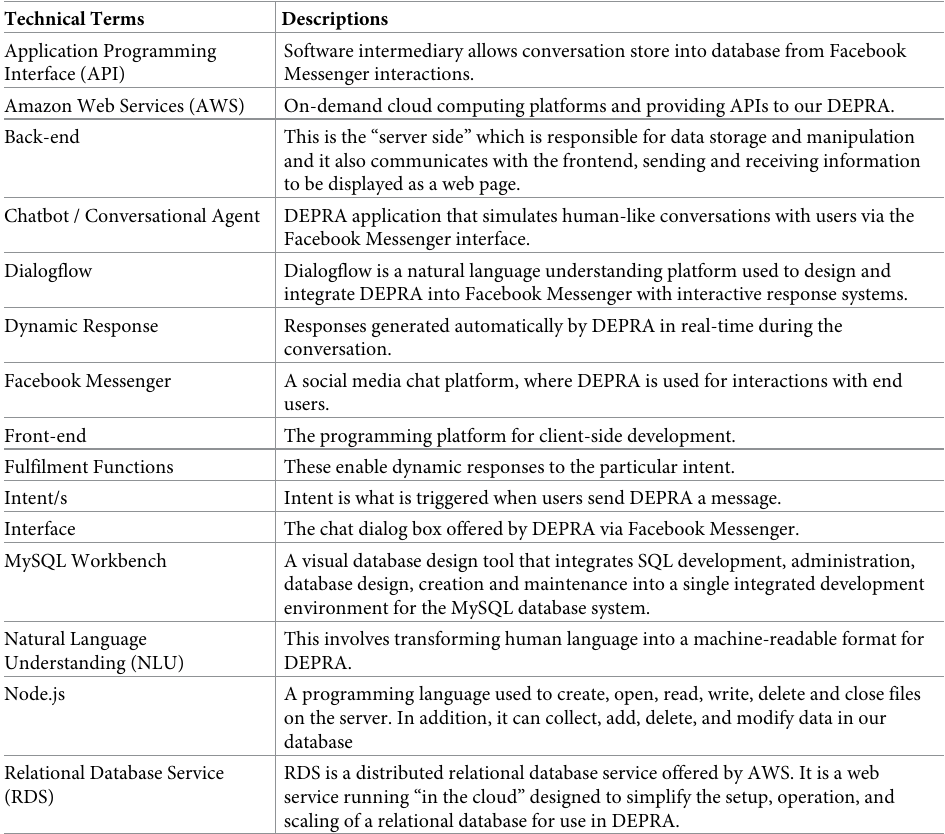
Table 1. Descriptions of technical